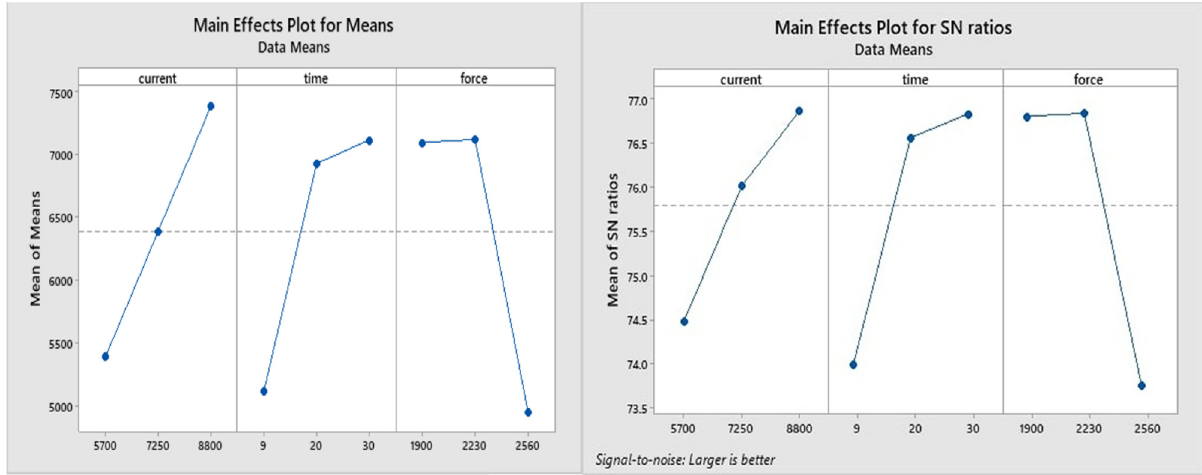
Figure 15: Main e ff ect plot for SN ratio and for mean values using Taguchi